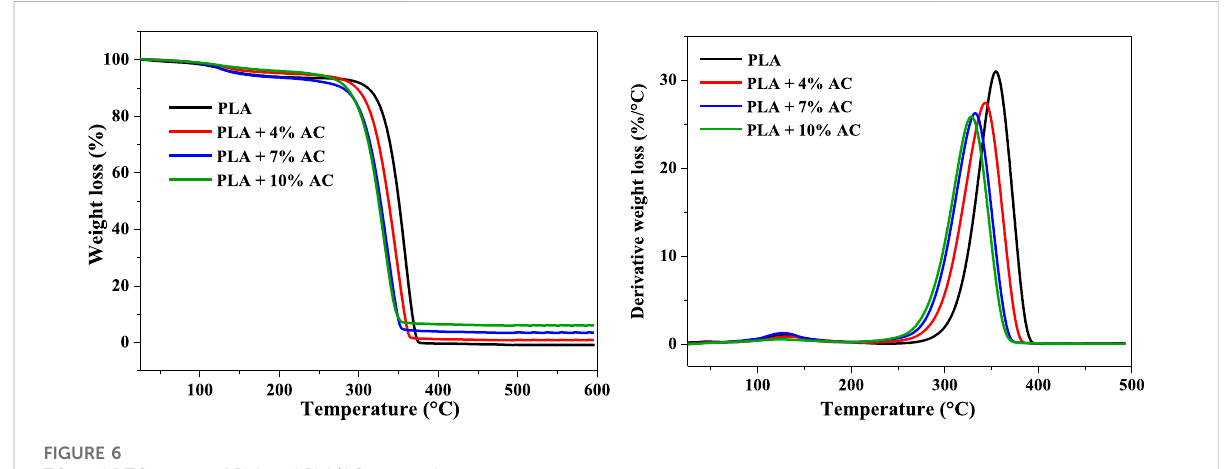
FIGURE 6 TG, and DTG curves of PLA and PLA/AC